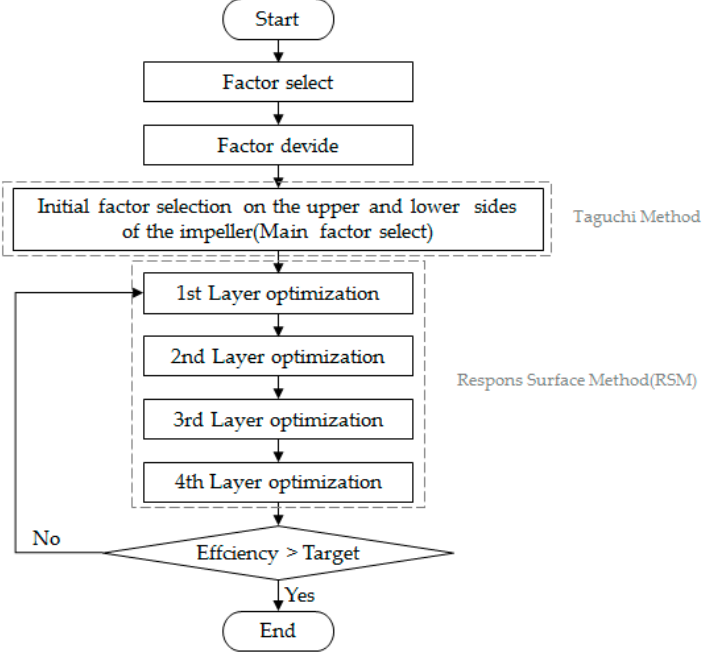
Figure 8. Flowchart of the iteration method for blade